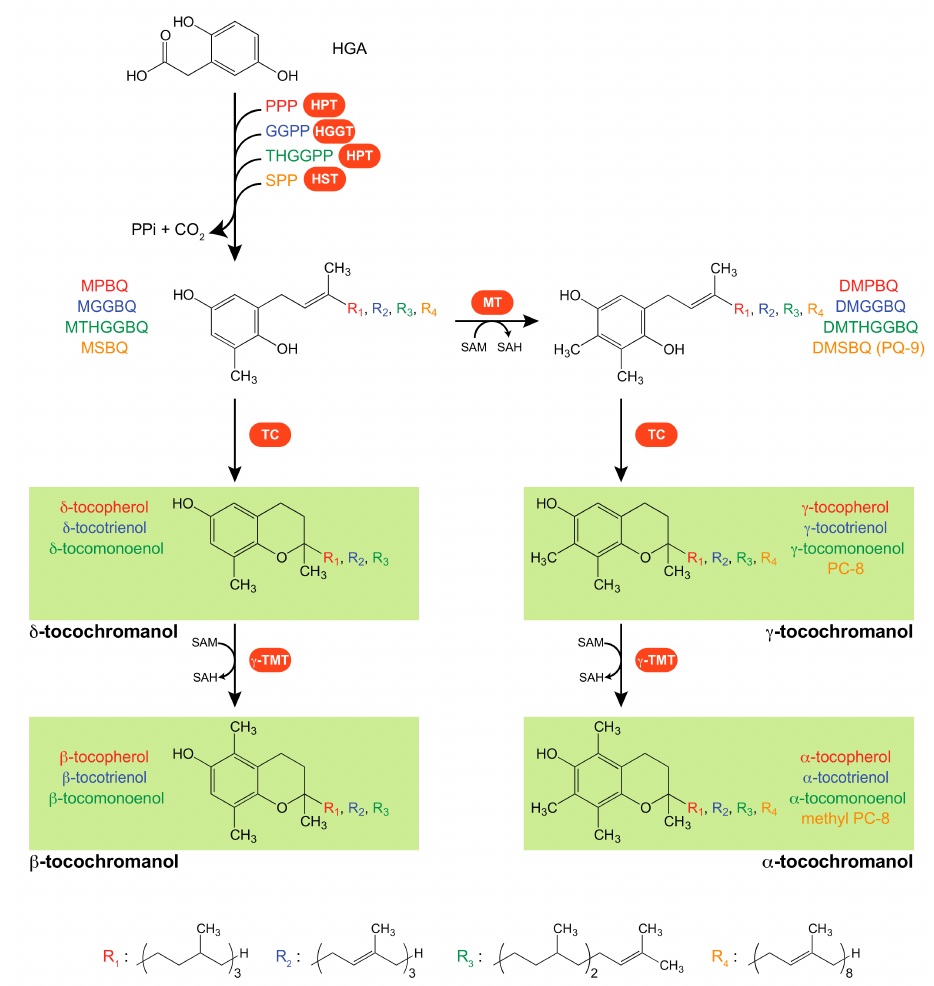
Figure 1. Tocochromanol biosynthetic pathways in plants. Tocochromanol and prenyl benzoquinol chemical structures and biosynthetic enzymes (highlighted in orange). Tocochromanol and prenyl benzoquinol names are color-coded to distinguish each tocochromanol pathway: red for the tocopherol pathway, blue for the tocotrienol pathway, green for the tocomonoenol pathway, and orange for the PC-8 and methyl PC-8 pathway. The α -, β -, γ -, and δ -forms of tocopherols, tocotrienols, and tocomonoenols have been identified in plants. For solanesyl-derived tocochromanols, only PC-8 has been identified in wild-type plants, and only methyl PC-8 has been identified in transgenic Arabidopsis overexpressing the γ - TMT/VTE4 gene. Abbreviations: HGA, homogentisate; HGGT, homogentisate geranylgeranyltransferase; HPT, homogentisate phytyltransferase; HST, homogentisate solanesyltransferase; GGPP, geranylgeranyl pyrophosphate; γ -TMT, γ -tocopherol methyltransferase; MT, methyltransferase; PC-8, plastochromanol-8; PPi, pyrophosphate; PPP, phytyl pyrophosphate; PQ-9, plastoquinol-9; SAM, S -adenosyl- L -methionine; SAH, S -adenosyl- L -homocysteine; SPP, solanesyl pyrophosphate; TC, tocopherol cyclase; THGGPP, tetrahydrogeranylgeranyl pyrophosphate. Prenyl benzoquinol acronyms are detailed in the main